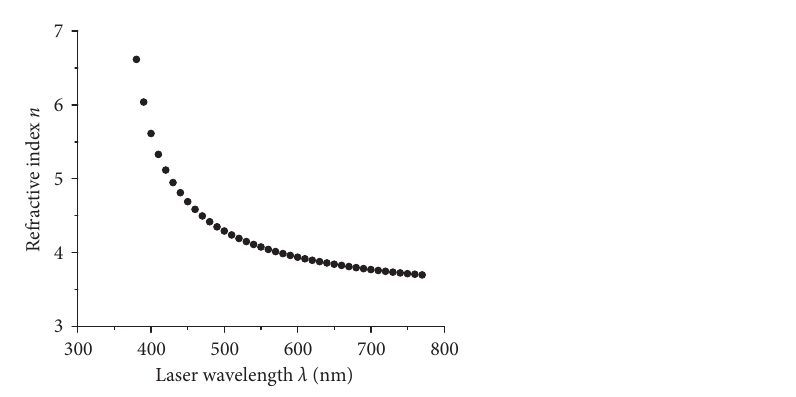
Figure 18: Refractive index of intrinsic silicon at 300K (visible